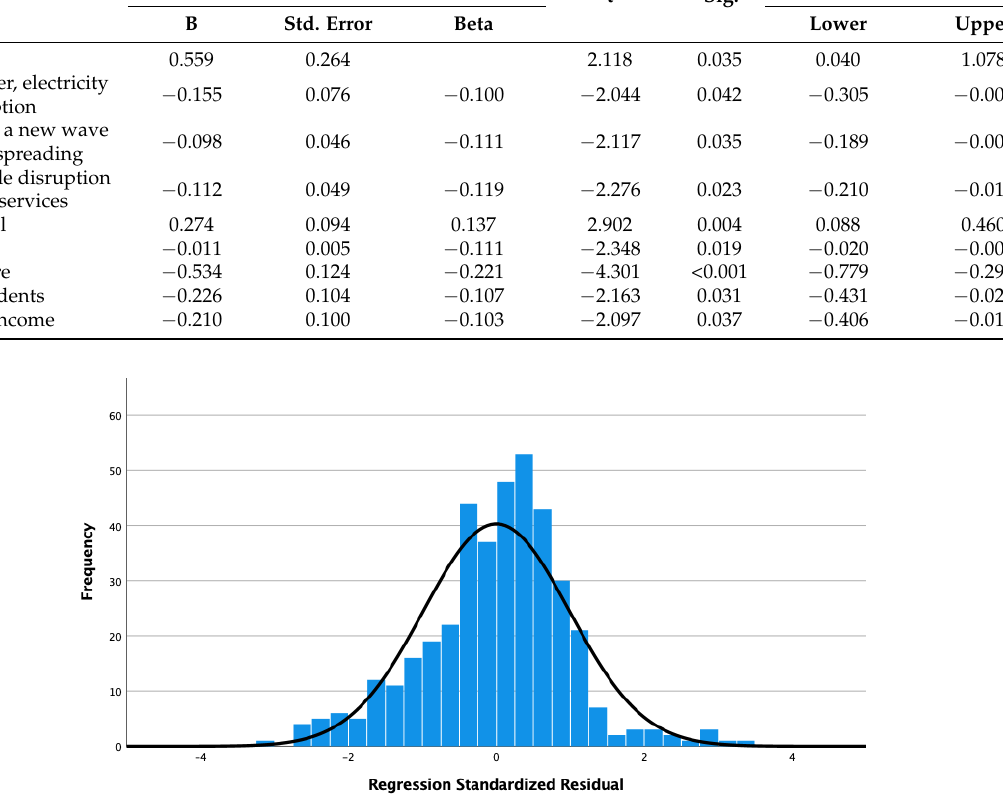
Figure 2. Histogram of the regression standardized residual.